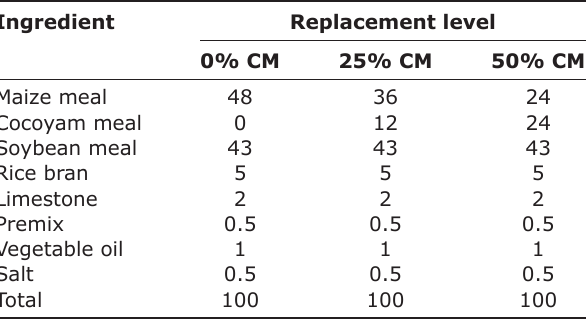
Table-1: Feed composition (in %) per kilogram of the three dietary treatments used as rations for finisher